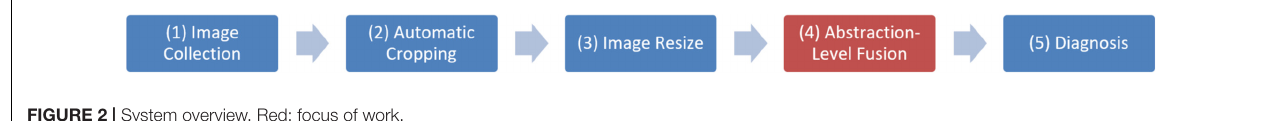
Abstraction-Level Fusion, is inspired by the work in Karpathy et al. (2014). In that work, a deep learning neural network is extended to process videos with three modes: early fusion, late fusion and slow fusion. In early fusion, frames are combined as input to the neural network. In late fusion, the additional video frames are injected into the first fully connected later. Slow fusion is a balanced version of both approaches. In Abstraction- Level Fusion, there are multiple levels of fully connected layers. Each fully connected layer receives low-level appearance features such as edge information or order statistics. The method in Karpathy et al. (2014) fuses temporal information, not additional appearance